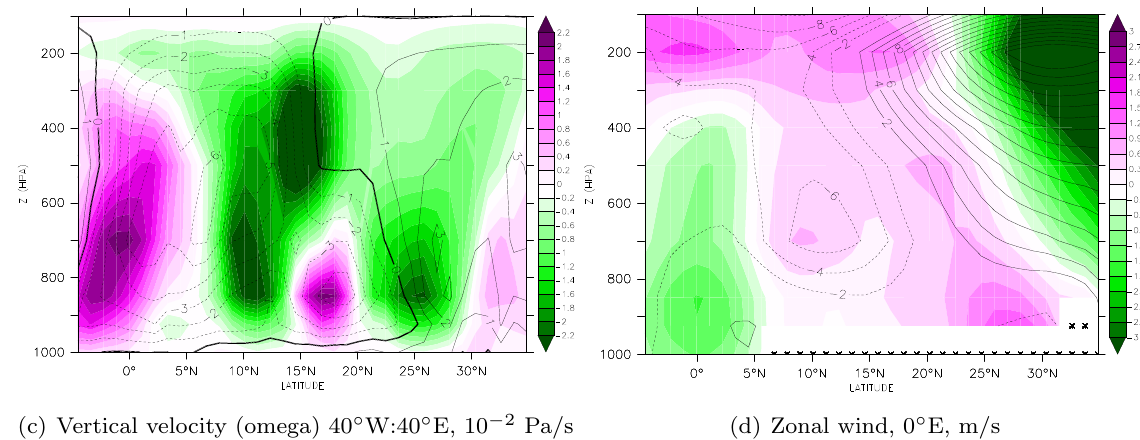
Fig. 8. MH-PI JAS differences in (a) evaporation (colours, mmday − 1 ) and wind speed (contours, ms − 1 ), (b) P-E (colours, positive values indicating moisture convergence, in mmday − 1 ) and moisture advection Q (vectors, vector length is 30kgms − 1 ), (c) vertical velocity in 10 − 2 Pas − 1 , averaged over 40 ◦ W:40 ◦ E (negative values indicating upward motion), (d) zonal wind velocity in ms − 1 at the meridian (0 ◦ E), positive values are westerly winds. White areas indicate where the pressure levels are below the surface. In panels (c) and (d) , colours give the MH-PI difference, contours indicate the PI climatology, and height is given in pressure coordinates, 500hPa is approximately